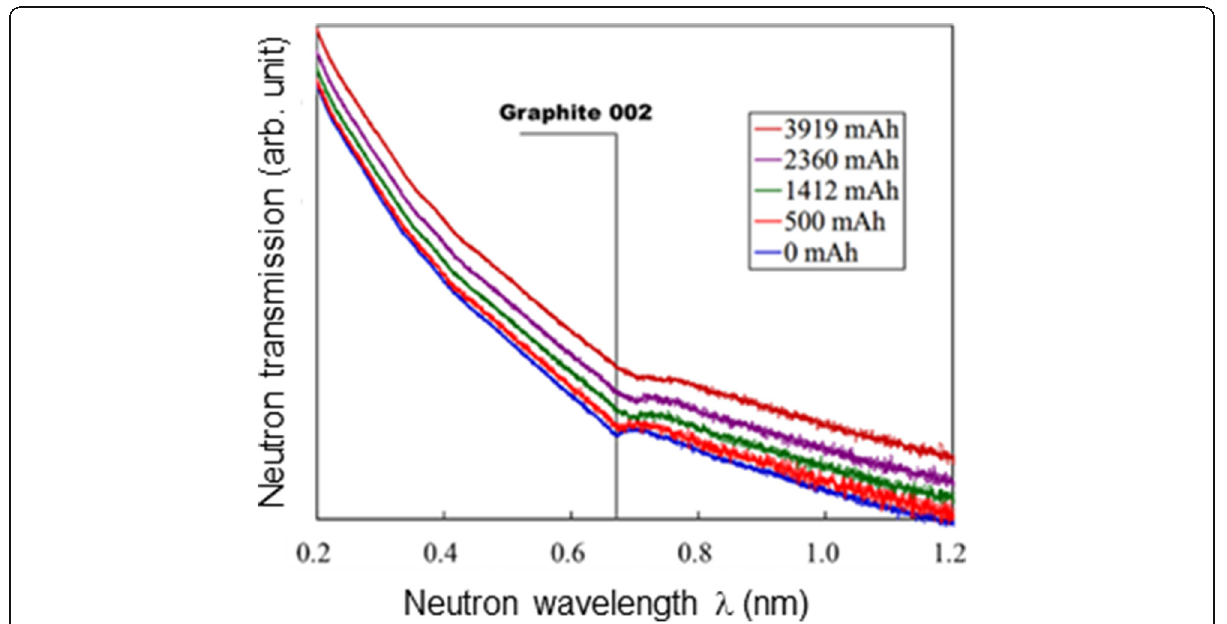
Fig. 11 Transmission spectra at different charge currents from 0 to 3919 mA